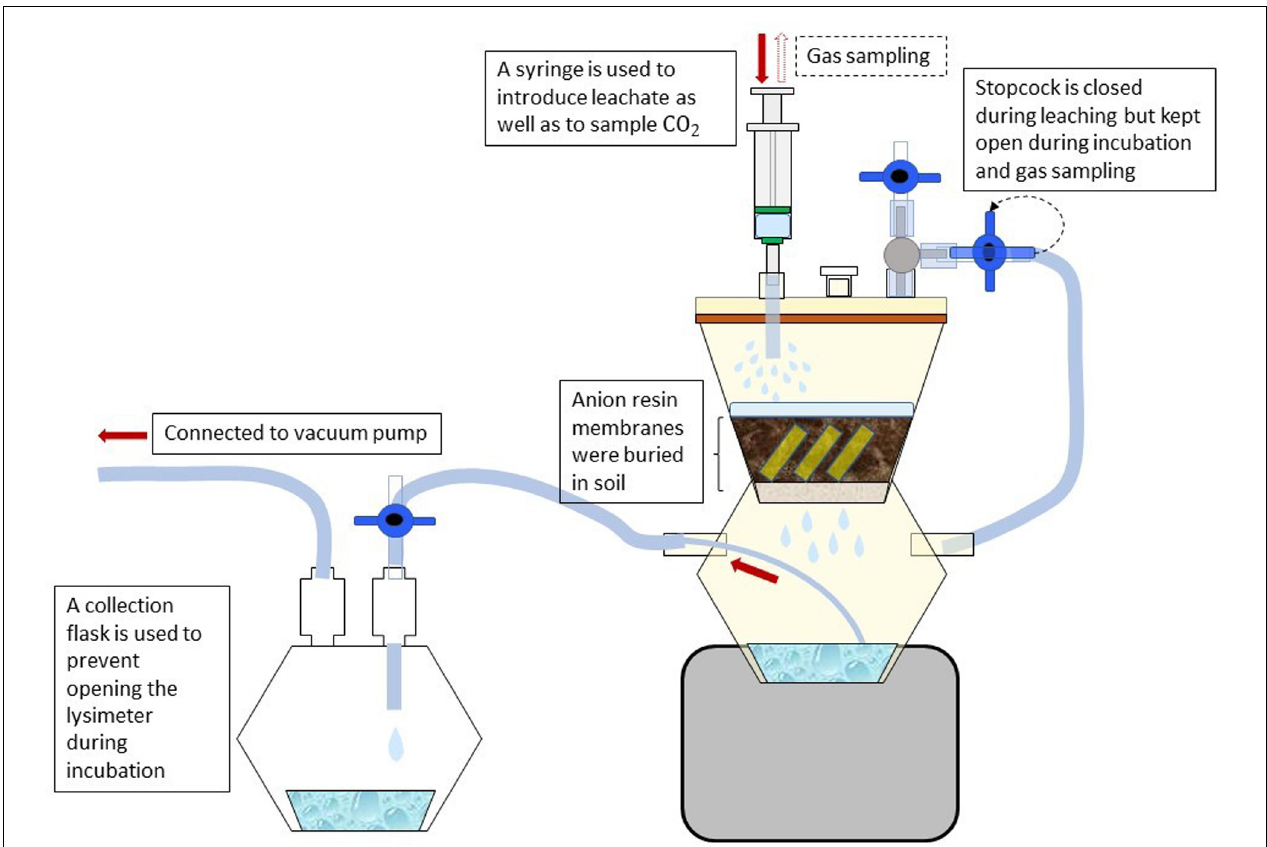
FIGURE 1 | Design of soil incubation and nutrient leaching using a microlysimeter. Samples were leached with weak salt solution to remove nutrients mineralized during incubation. A collection flask is used to retain the leachate from the bottom chamber of the microlysimeter using a vacuum pump. Resin membranes were used to capture phosphate mineralized during the